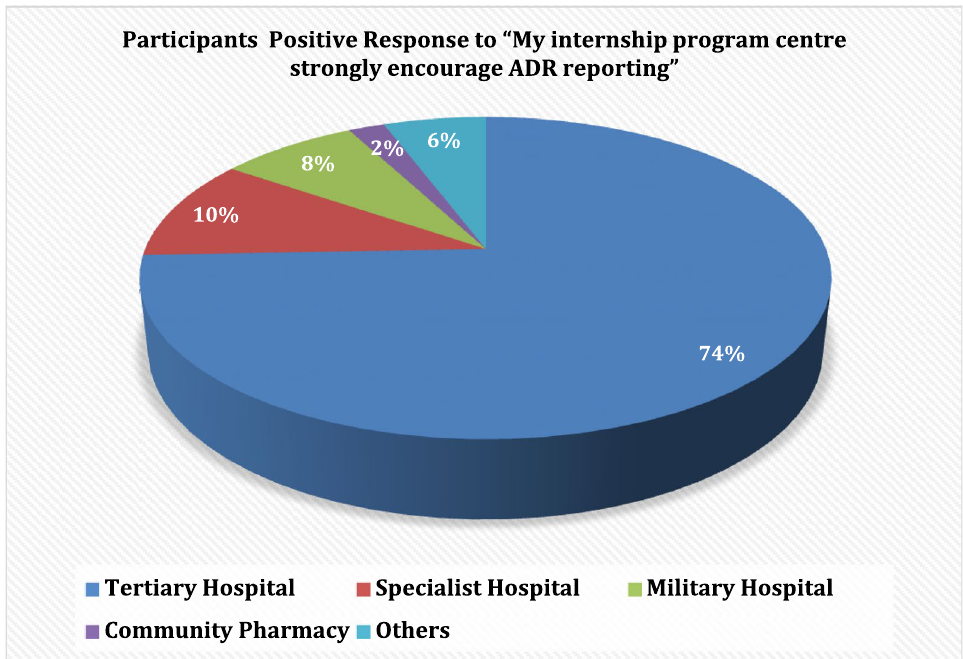
Fig. 3 Participants’ positive response to ‘My internship program center strongly encourage ADR reporting.’ 74.0% of those with positive responses are from participants in tertiary hospitals, followed by those in specialist hospitals (10%) and military hospitals (8%). Community pharmacy scored the least, with a positive response of